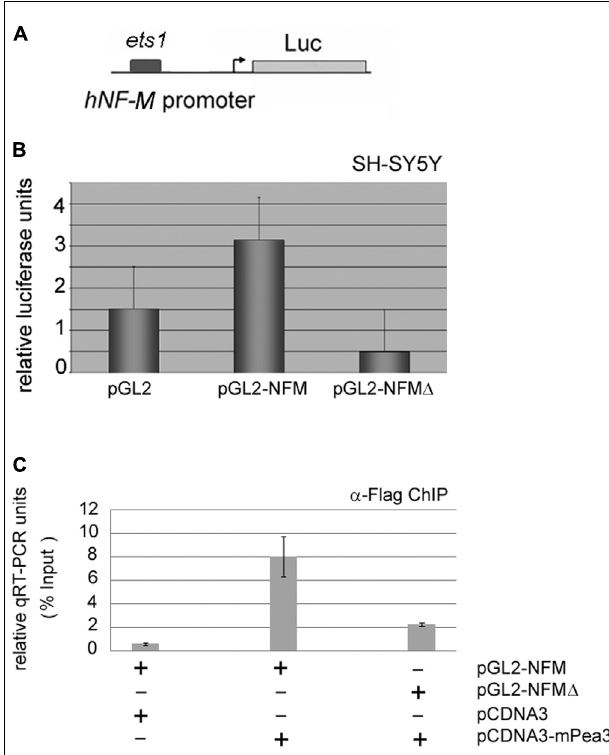
FIGURE 6 | Neurofilament-M as a potential target promoter for activation by Pea3. (A) hNF-M promoter, which contains 1 major ets motif, was cloned upstream of a luciferase reporter gene; (B) luciferase reporter gene expression assay with either wild type 200 ng of NFM promoter or NFM- (cid:2) with deletion of putative Pea3 transcription factor binding site, in SH-SY5Y cells (luciferase activities represent reproducible three to four independent experiments and data plotted for each condition were average of relative luciferase activity of triplicate samples); (C) quantitative PCR results of chromatin immunoprecipitation (ChIP) assay, where Flag-tagged mPea3 expression plasmid was co-transfected into the HEK293 cells with or without NFM wild type and NFM- (cid:2) luciferase reporter, subjected to chromatin precipitation with anti-Flag antibody and purified DNA material was amplified with NF-M gene promoter